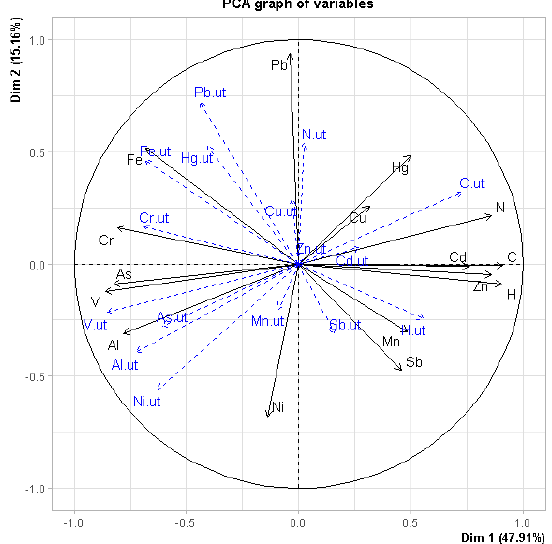
Figure 8. PCA results, first factor plane. Correlation circle of the (clr-transformed) concentrations of elements (in black) and untransformed data (in blue).